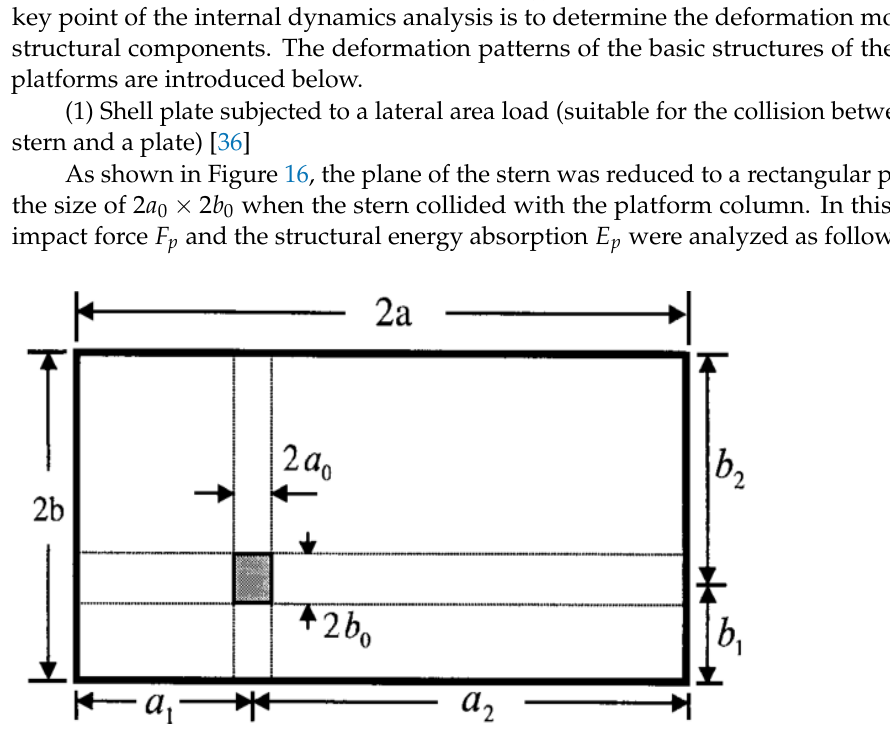
Figure 16. The schematic diagram of the rectangular plate impacted by rectangular load.